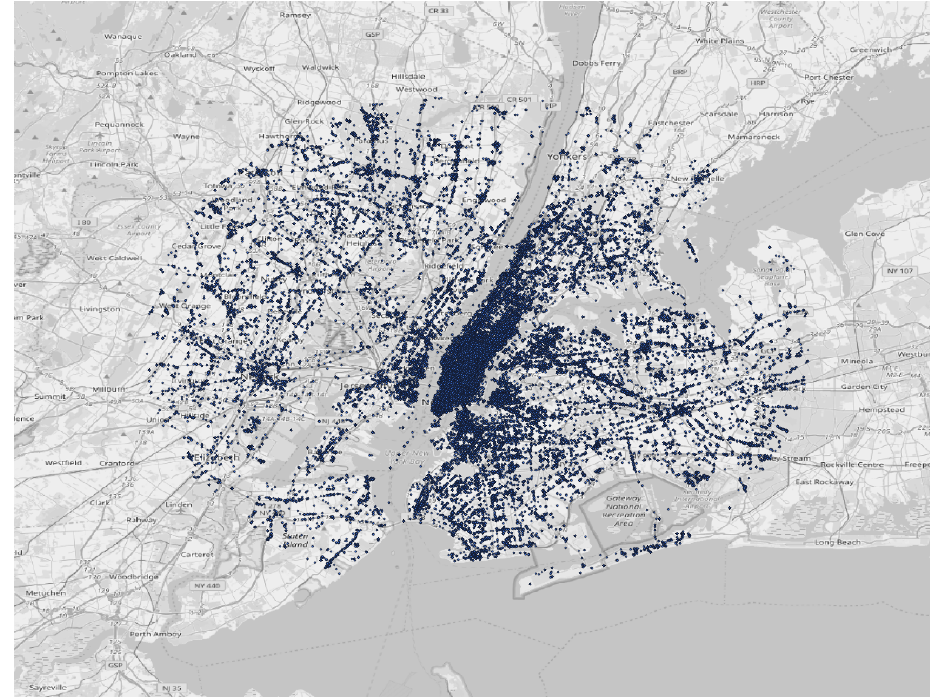
Figure 4. NYC FourSquare check-ins.